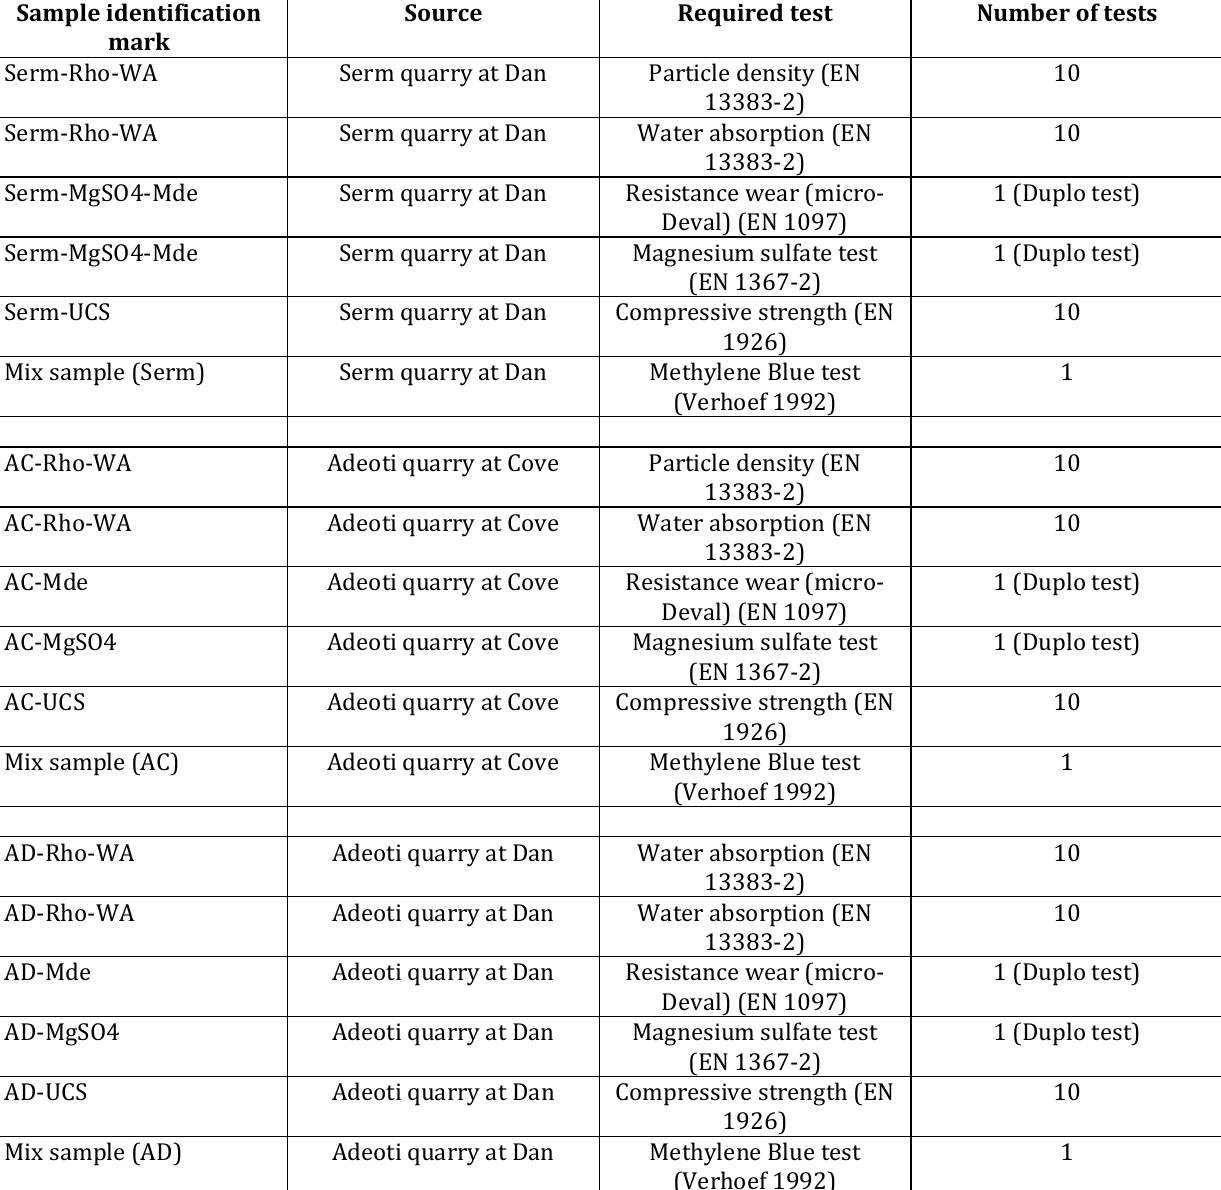
Table 1. Overview test program and sample identification Sample